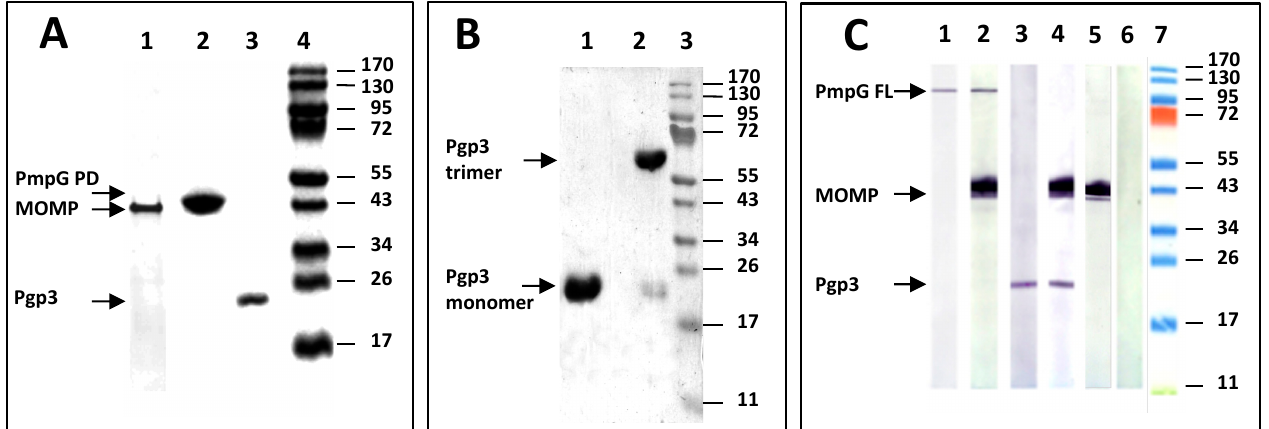
Figure 1. Characterization of the recombinant C. muridarum proteins used as antigens. ( A ): Silver- stained 10% SDS-PAGE of the C. muridarum recombinant proteins used as antigens. Lane 1: